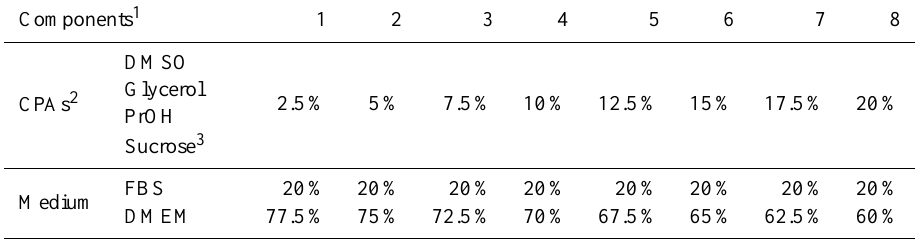
Table 1. The components of different cryoprotectants (volume ratio). Components